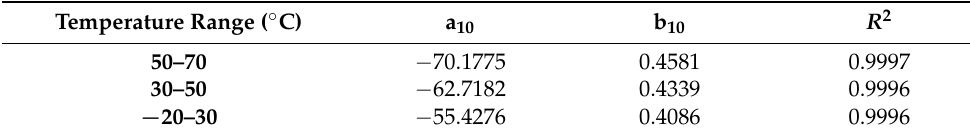
Table 4. The Landsat 8 TIRS band 10 coefficients a10 and b10